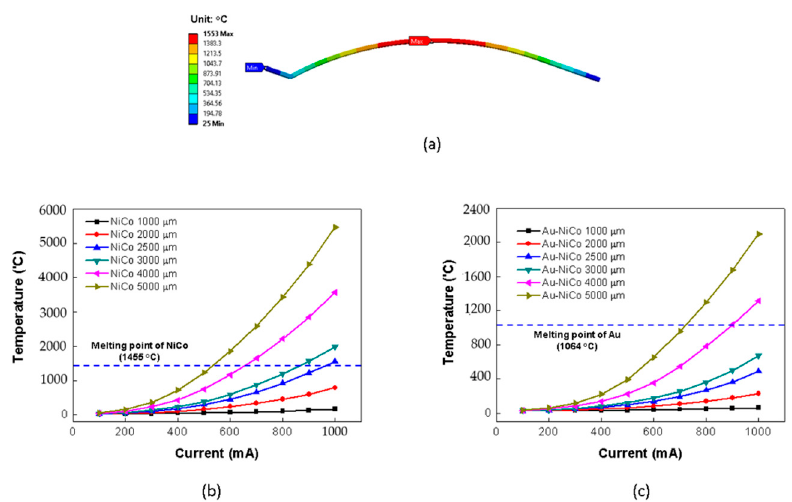
Figure 5. ( a ) Simulated distribution of the temperature generated when a current of 1000 mA flowed through the 2500 µm-long NiCo probe. ( b ) Results for temperature of the NiCo probe with increasing current for different probe lengths. ( c ) Results for temperature of the Au–NiCo probe with increasing current.